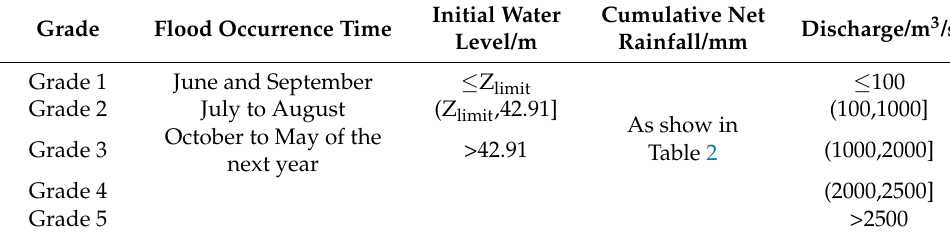
Table 3. Classification of all attributes.